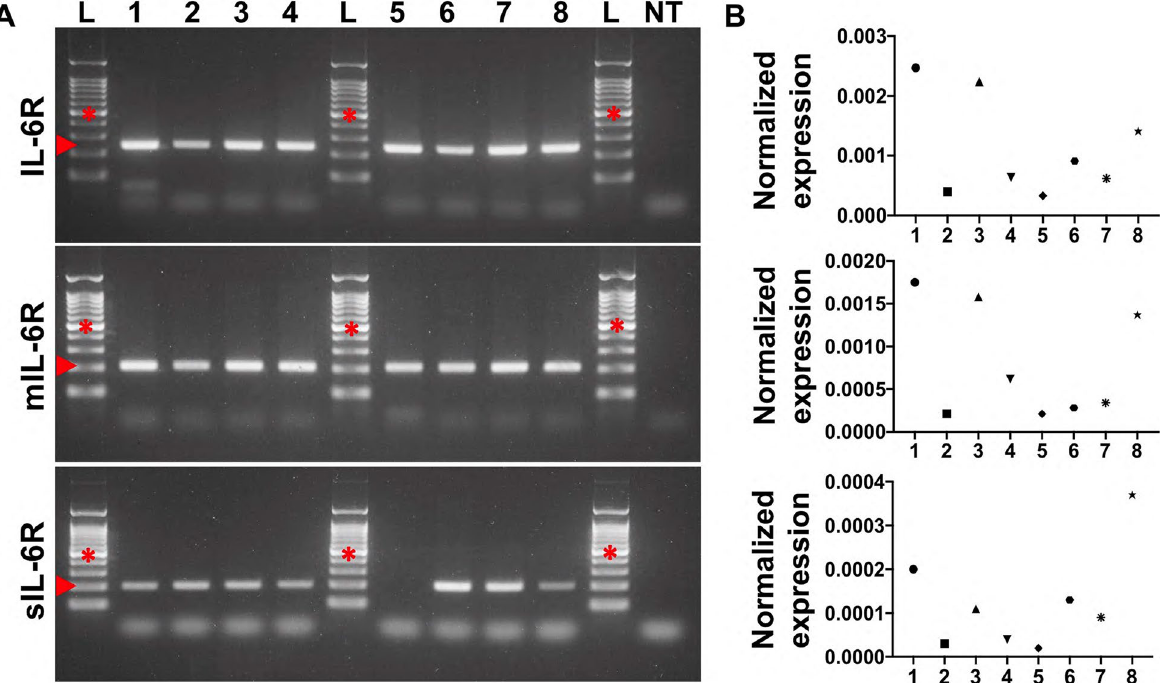
Fig. 1 IL-6R transcript expression in human retinal endothelial cells. A Images showing IL-6R amplicons run on 2% agarose gel. L: DNA ladder (500 base pairs indicated by red cross); 1–7: primary retinal endothelial cell isolates from individual donors; 8: expanded retinal endothelial cell isolate; NT: no cDNA template control. Expected product sizes (indicated by red arrows): IL-6R: 240 bp; mIL-6R: 202 bp; sIL-6R: 195 bp. B Graphs showing relative normalized expression of corresponding IL-6R transcripts in the same cell isolates showed in ( A ). Reference genes were RPLP0 and